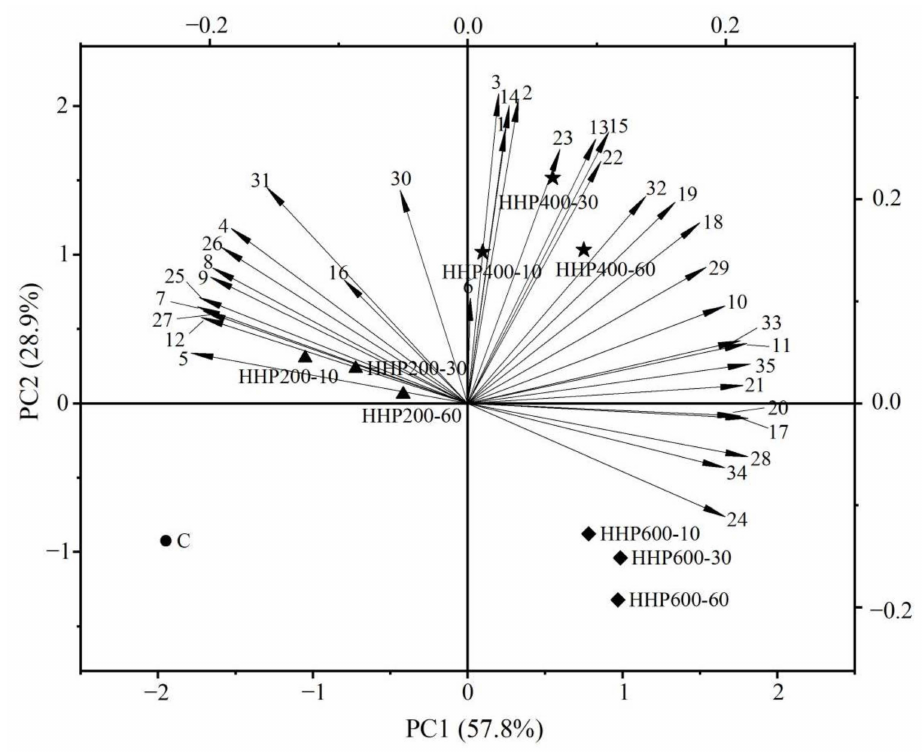
Figure 3. PCA of the control and samples. Annotation: (1) 2-methylpropanal; (2)